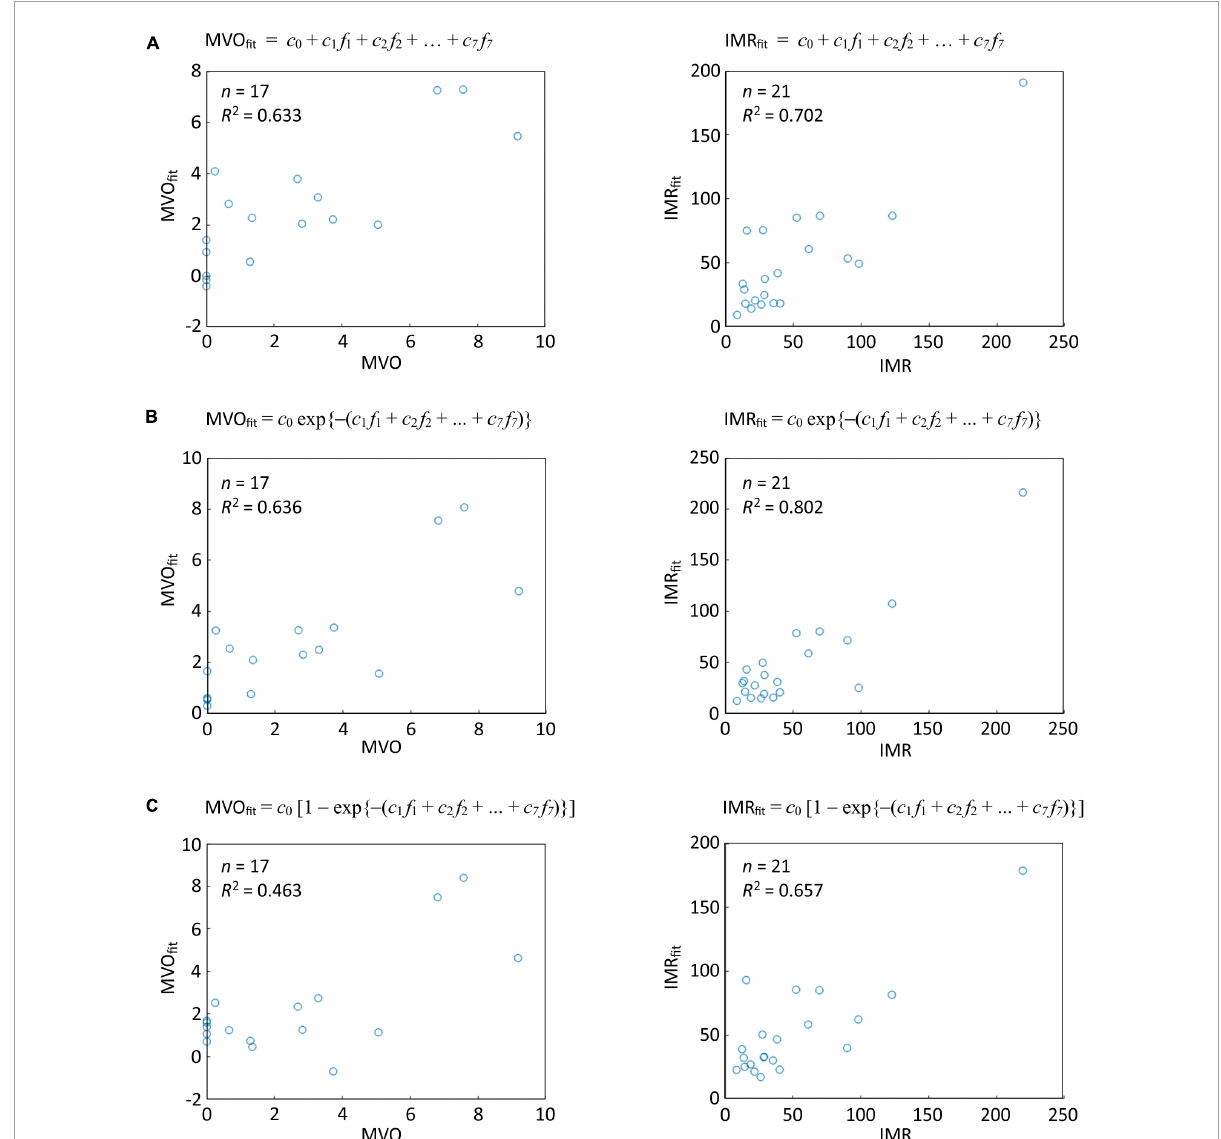
FIGURE6 Linear regression analysis of correlations between thrombus spectral parameters predicted microvascular injury and actual microvascular injury indices for the thresholded data set of Oxford Acute Myocardial Infarction (OxAMI) samples. The plots show fits of the thrombus pixel k -fractions determined from the spectral images in the thresholded data set to (A) Eq. 2; (B) Eq. 4; and (C) Eq. 5. Note that the fitting coefficients c k are different for each fit. Sample number n and R 2 value are shown for each correlation. Equivalent plots for the full OxAMI data set can be found in Supplementary Figure 3